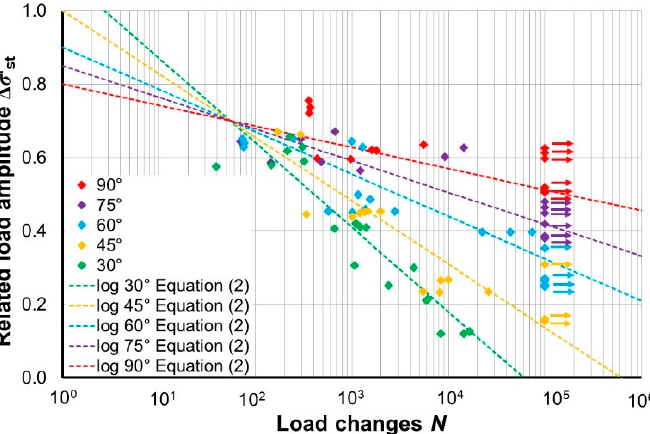
Figure 4. S/N-curves of pullout tests with fibre groups in relation to the fibre orientation.